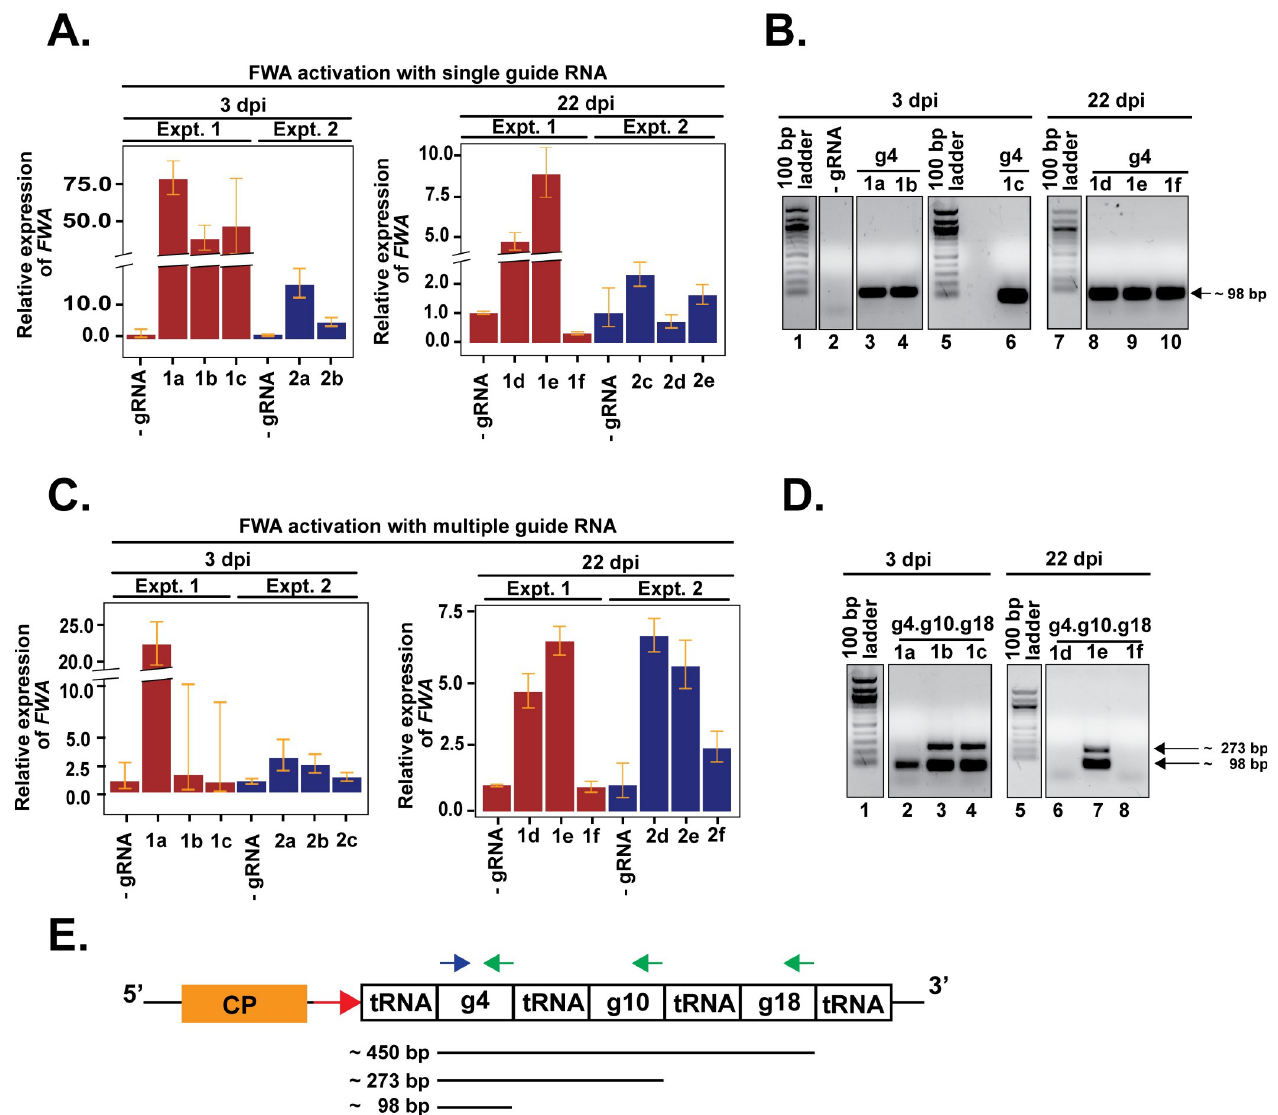
Fig 1. TRV-mediated guide RNA delivery in SunTag-VP64 plants causes transcriptional activation of FWA . Reverse transcriptase-qPCR was performed on total RNA extracted from leaves of individual plants at different time points post TRV inoculation to examine the accumulation of FWA mRNAs by single guide RNAs (A) and multiple guide RNAs (C). Fold expression change is relative to control plants inoculated with TRV with no guide RNA. Left panel shows FWA expression in samples collected from 3 dpi inoculated leaves and right panel shows samples from 22 dpi upper uninoculated cauline leaves in (A) and (C). Experiment 1 (Expt.1) and experiment 2 (Expt.2) indicate two independent biological experiments, each using multiple plants. Individual samples are denoted as “1a”, “2a” and so on. The prefix 1 or 2 denotes the experiment, the alphabets “a”, “b” denotes individual plants. Error bars indicate standard deviations (n = 2 technical replicates for experiment 1, and n = 3 technical replicates for experiment 2). To simplify labelling, TRV with no guide RNA is denoted as-gRNA, TRV with guide 4 as g4, and TRV with multiple guides as g4.g10.g18. Agarose gel electrophoresis of reverse transcriptase PCR products amplified to detect guide RNA specific sequences in g4 (B) and g4.g10.g18 (D) inoculated plants from experiment 1. 100 bp band corresponds to guide 4 sequence (98 bp), while 273 bp likely corresponds to unprocessed guide 4 sequence containing RNAs. Numbers at the bottom of the gels indicate lanes with samples or DNA ladder. Samples run on the lane numbers that are grouped here in parentheses (1–4), (5–6), (7–10) in (B) and (1–4), (5–8) in (D) were run on the same gel. In addition, lane (5–6) in (B) and (1–4) in (D) were run on the same gel and so have a common marker. (E) Schematic representation of primer binding sites from (B) and (D) in the modified viral RNA2 containing three separate guide RNAs. Blue arrow indicates the forward primer, green indicates reverse primers. Red arrow downstream of Coat protein (CP) denotes the sgPeBV promoter. Expected sizes of PCR products are shown at the bottom.